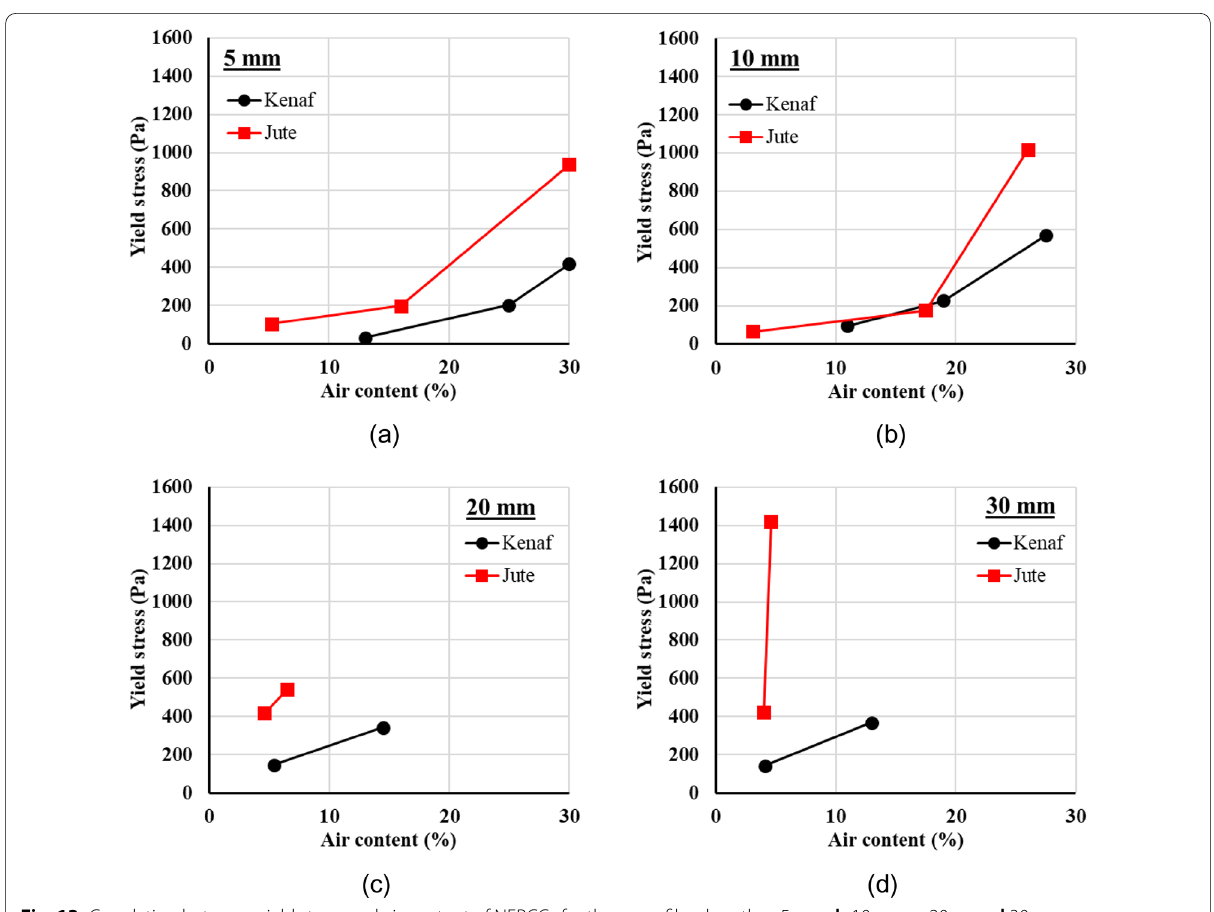
Fig. 13 Correlation between yield stress and air content of NFRCCs for the same fiber length: a 5 mm; b 10 mm; c 20 mm; d 30